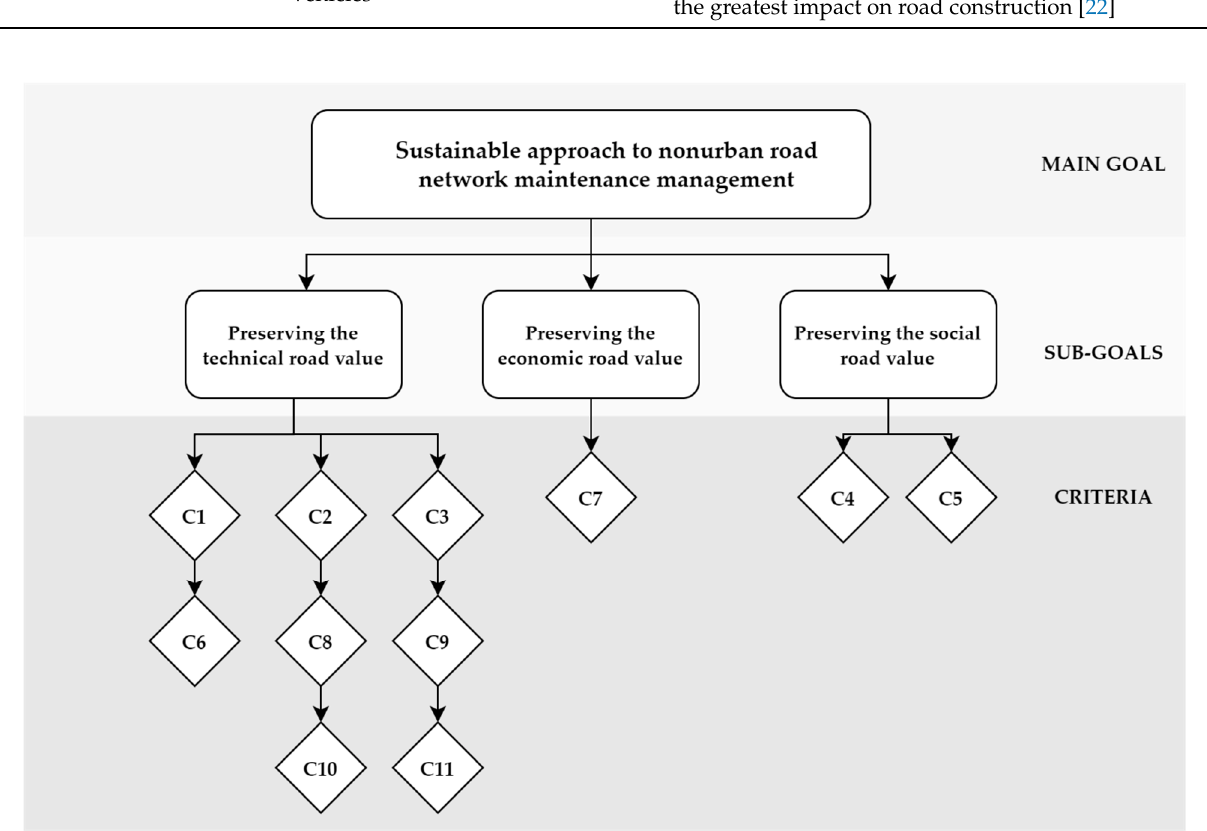
Figure 4. Hierarchical structure of goals.